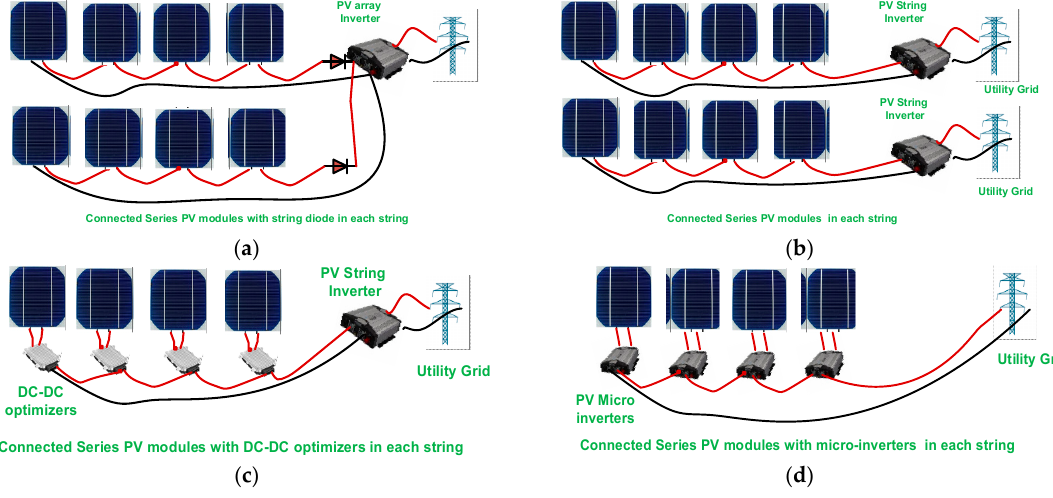
Figure 1. Traditional and recent photovoltaic (PV) architectures: ( a ) traditional system with centralized inverter; ( b ) traditional system with string inverters; ( c ) traditional system with string inverters and direct current (DC) optimizer; ( d ) recent PV architectures (module inverters).